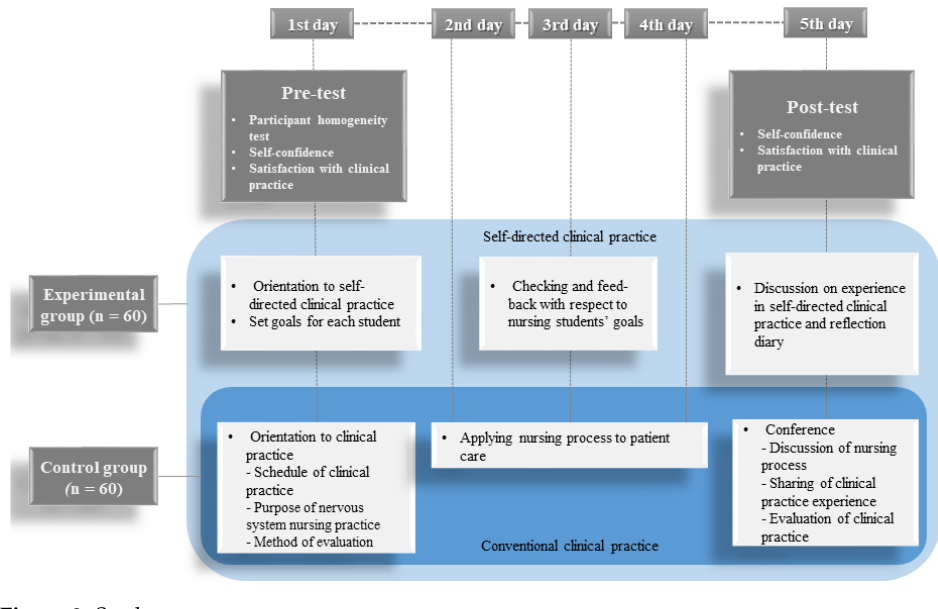
Figure 2. Study process.